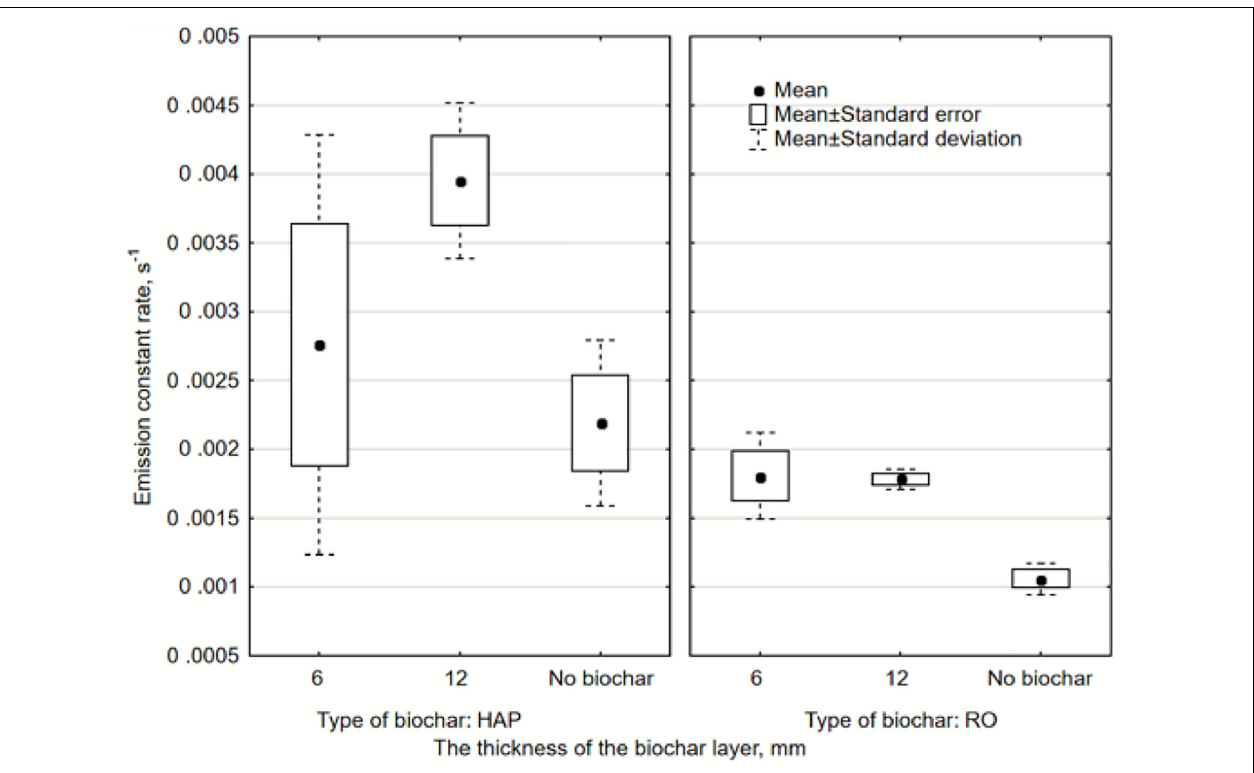
TABLE 5 | Biochar (HAP) treatment: the maximum peak flux and total NH 3 emission during 3 min agitation (bold font signifies statistical significance).